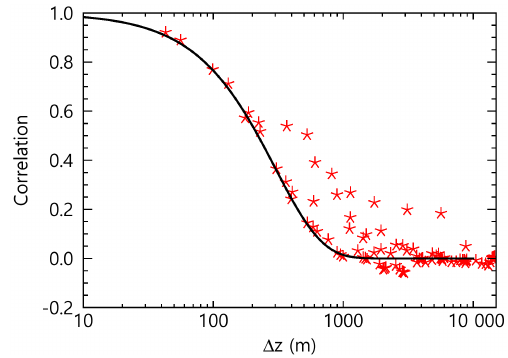
Figure 11. Model error correlation coefficients between two layers, as a function of (cid:49)z (the distance between two levels). The fitted line − (cid:49)z 1 . 2 l 1 . 2 is R = e